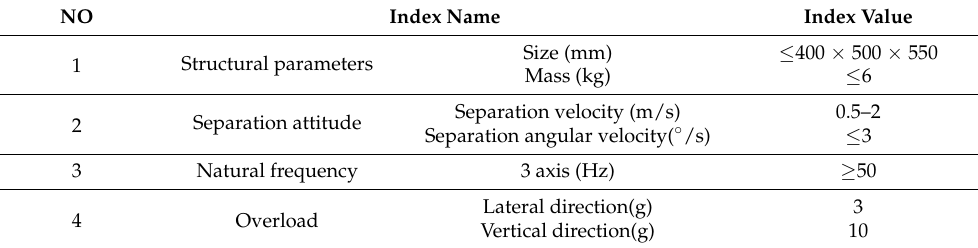
Table 1. Indexes for separation mechanism.